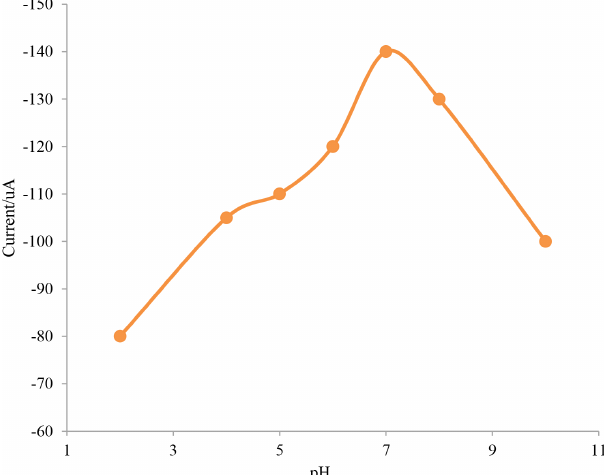
Figure 10. Temperature effect on Aeromonas hydrophila DNA biosensor response in temperature range 15–39 ◦ C); optimum 37 ◦